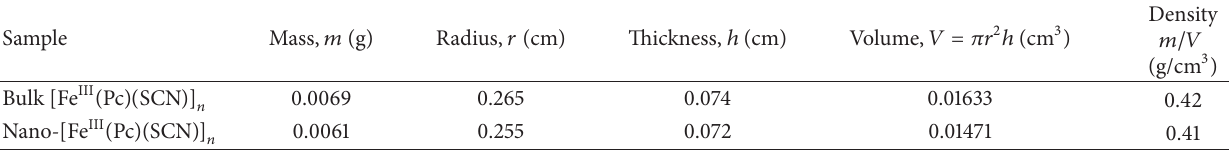
Table 3: Density of measured samples for